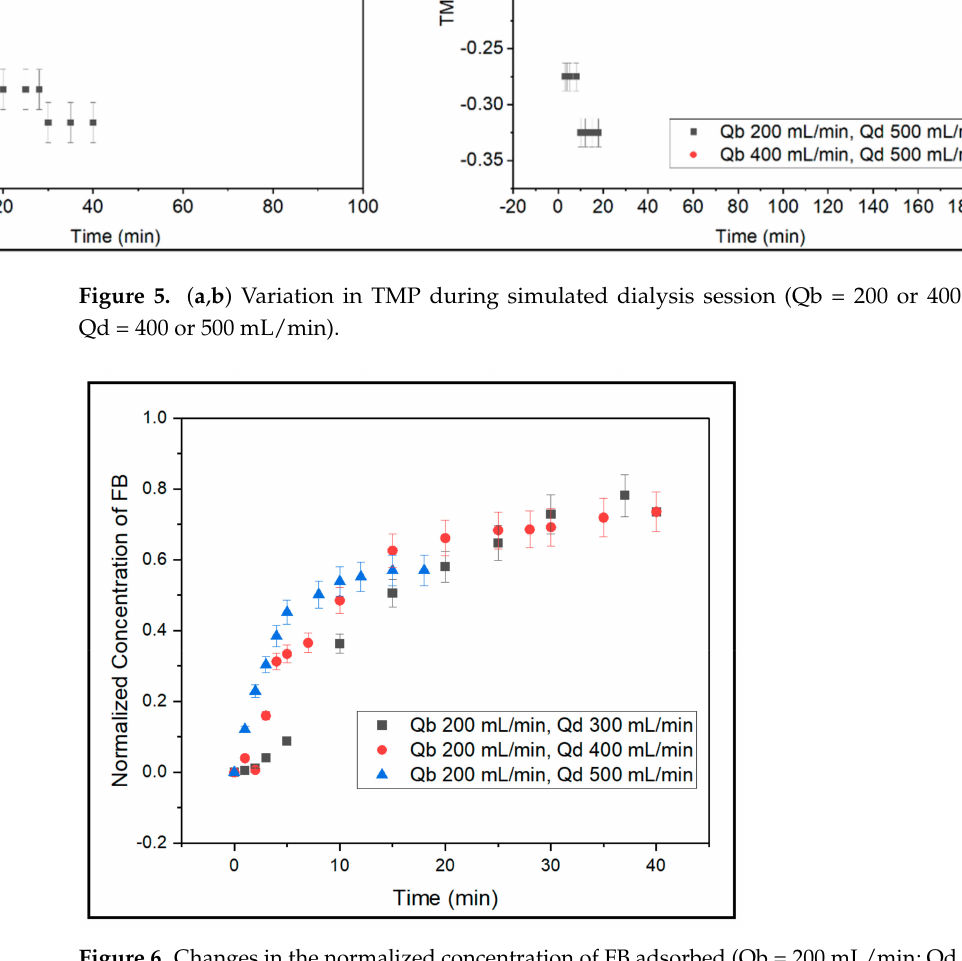
Figure 6. Changes in the normalized concentration of FB adsorbed (Qb = 200 mL/min; Qd = 300, 400, or 500